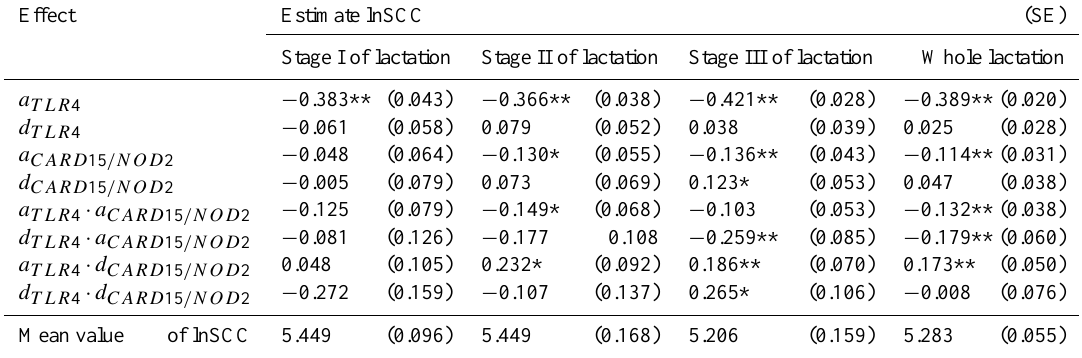
Table 3. Additive, dominance and epistatic effects of TLR4 and CARD15/NOD2 with regard to lnSCC in selected stages of lactation.